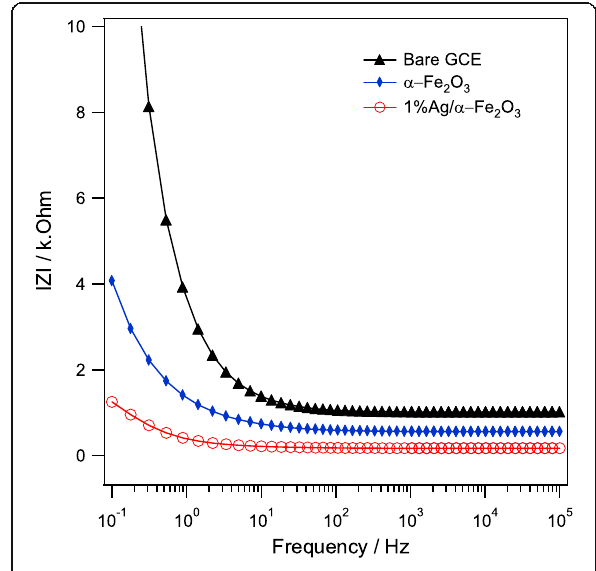
Fig. 8 EIS bode plots measured in 0.1 M PBS using bare GCE, α − Fe α − Fe 2 O 3 , and 1%Ag/ 2 O 3 -modified GCEs at 5 mV potential amplitude, 0.0 V vs. Ag/AgCl in a frequency range of 0.1 Hz – 100 kHz